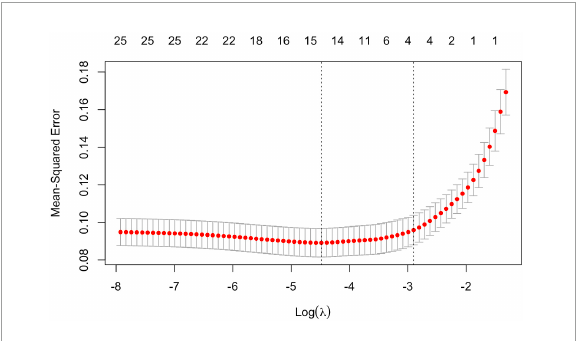
FIGURE3 Important variables identified with ten-fold cross-validation.